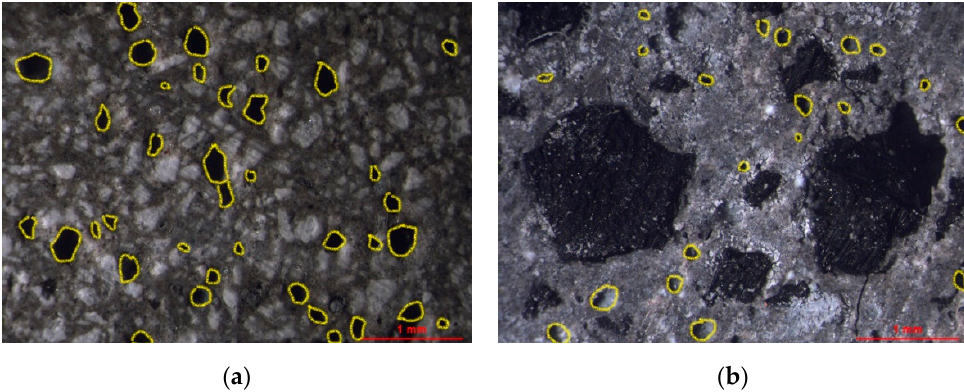
Figure 3. Optical microscopy analysis on cement-based samples: porosity distribution in Ref. ( a ) and CSM ( b ).